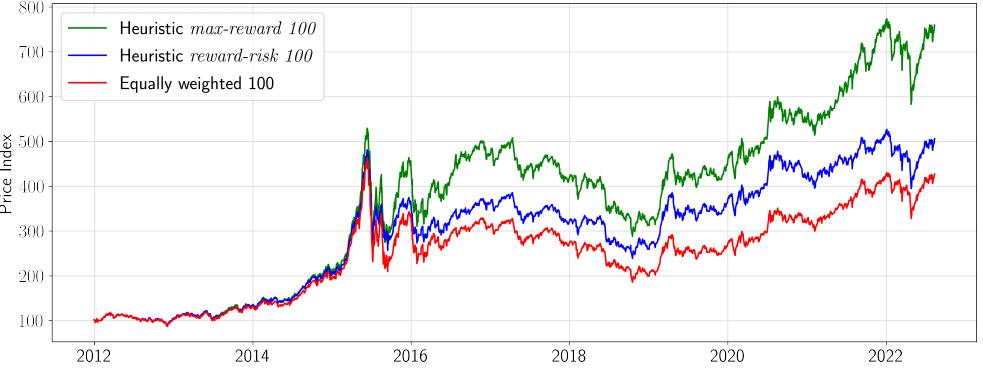
Figure 2. Out-of-sample price performance of the heuristic reward-risk (in blue line), the heuristic max-reward (in green line) and the equally weighted (in red line) portfolios with the 100 stocks.